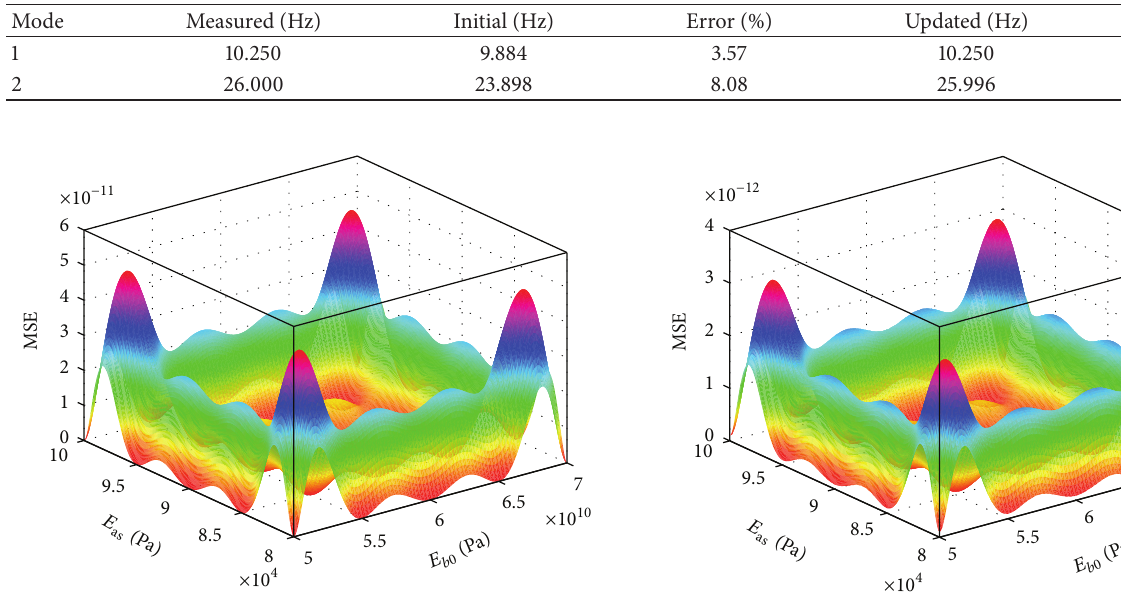
Figure 12: Mean squared errors of the second natural